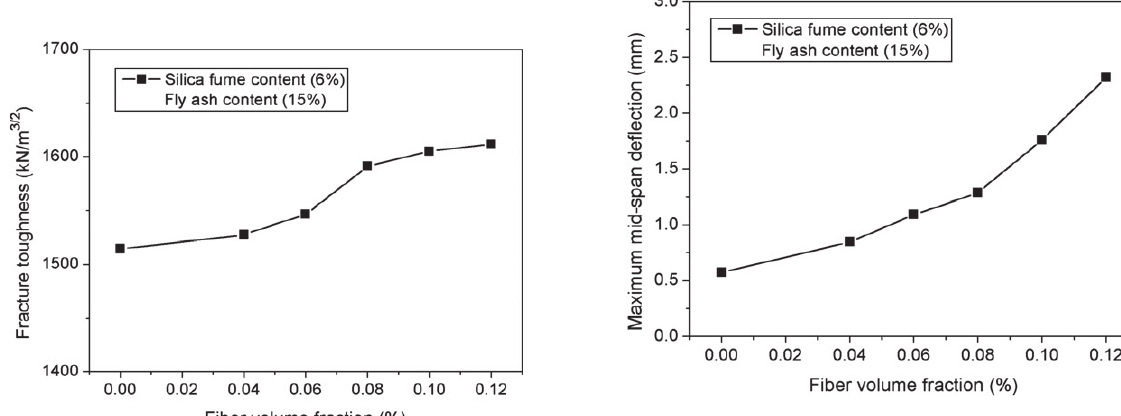
Figure 8 Effect of the polypropylene fiber on the maximum midspan deflection.